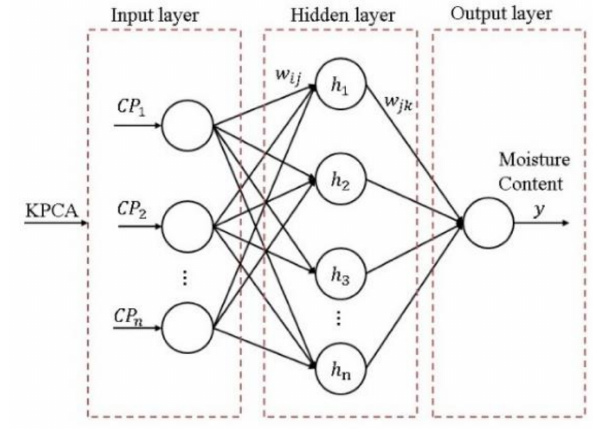
Figure 3. Basic structure of